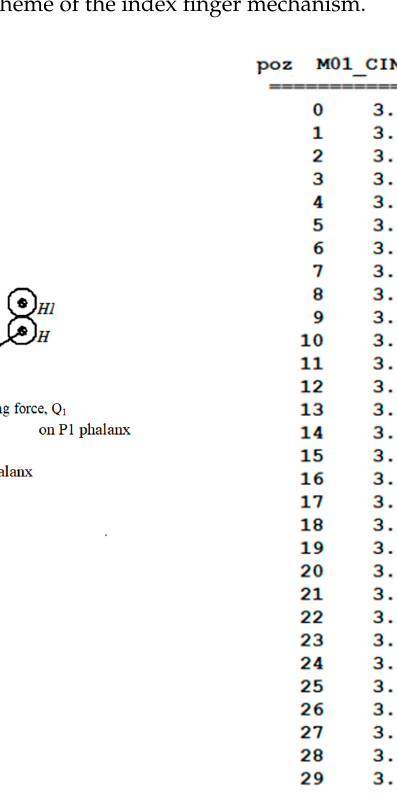
Figure 11. Kinetostatic scheme of the index finger mechanism.